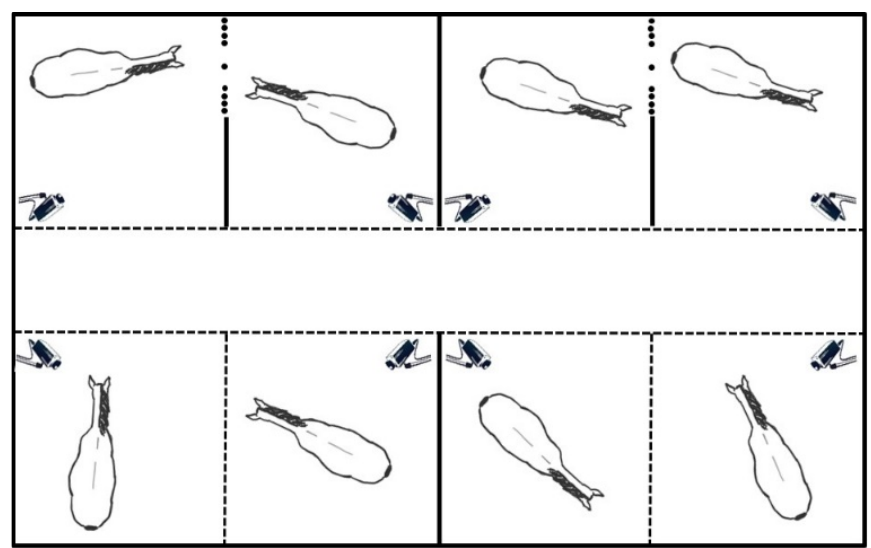
Figure 3. Experimental stables with 2 × 2 social boxes (above) and 2 × 2 conventional boxes (below). An opaque partition prevents visual and tactile contact between the two sets of box stalls, thus allowing tactile contact only within the same pairs.